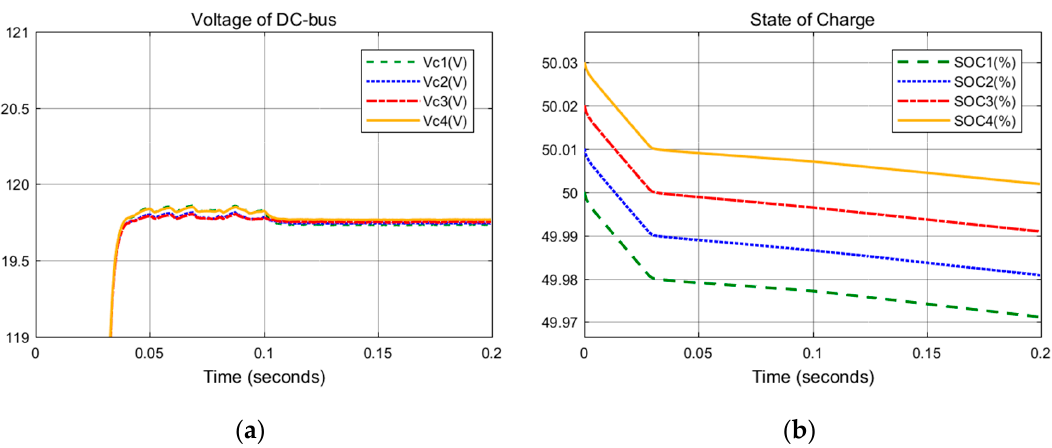
Figure 13. Primary control when the load variation is at 0.1 s of DCES 1 : ( a ) DC-bus voltage; ( b ) battery SOC.